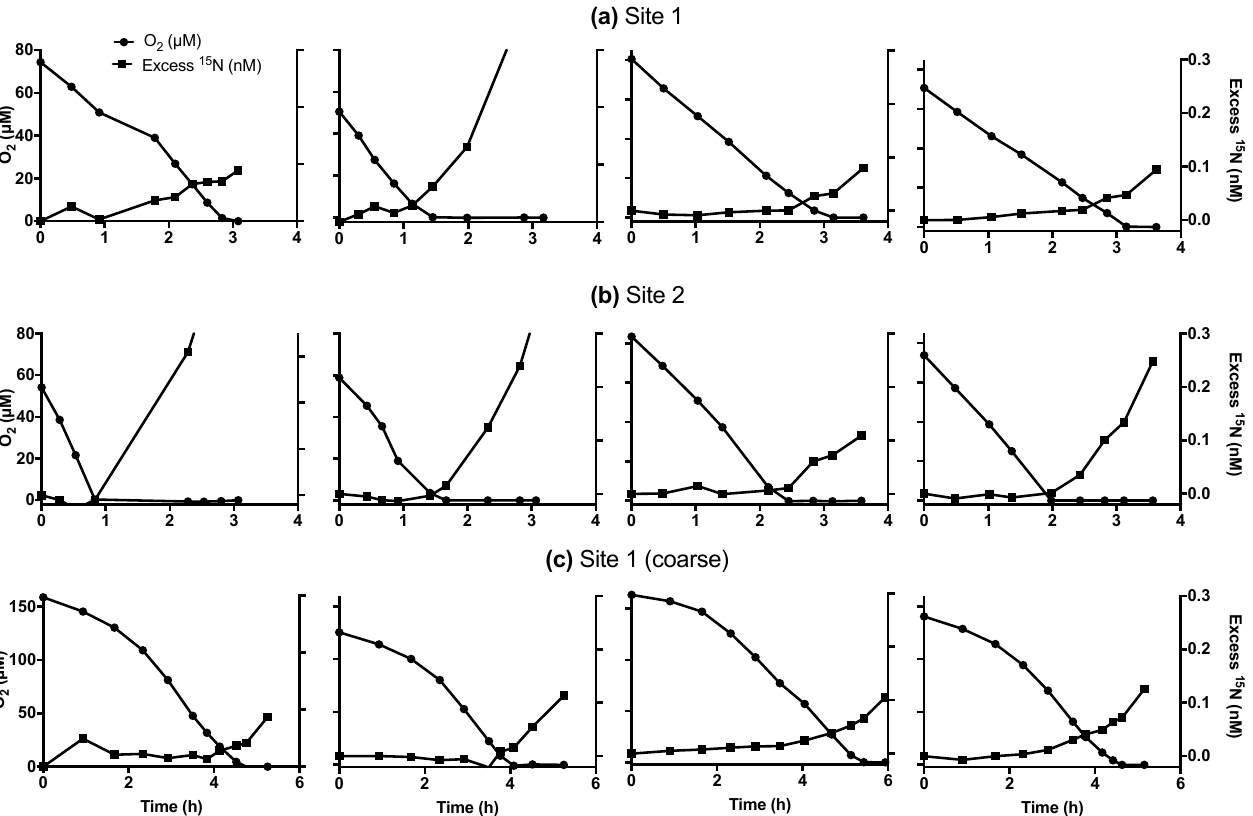
Figure 5. Time series of oxygen and excess 15 N–N 2 in stirred reactor experiments on sediments taken from sites 1 (a) and 2 (b) as well as the coarse fraction of sediment ( > 2mm) collected from site 1 (c) . Each row shows four replicate experiments for each site.